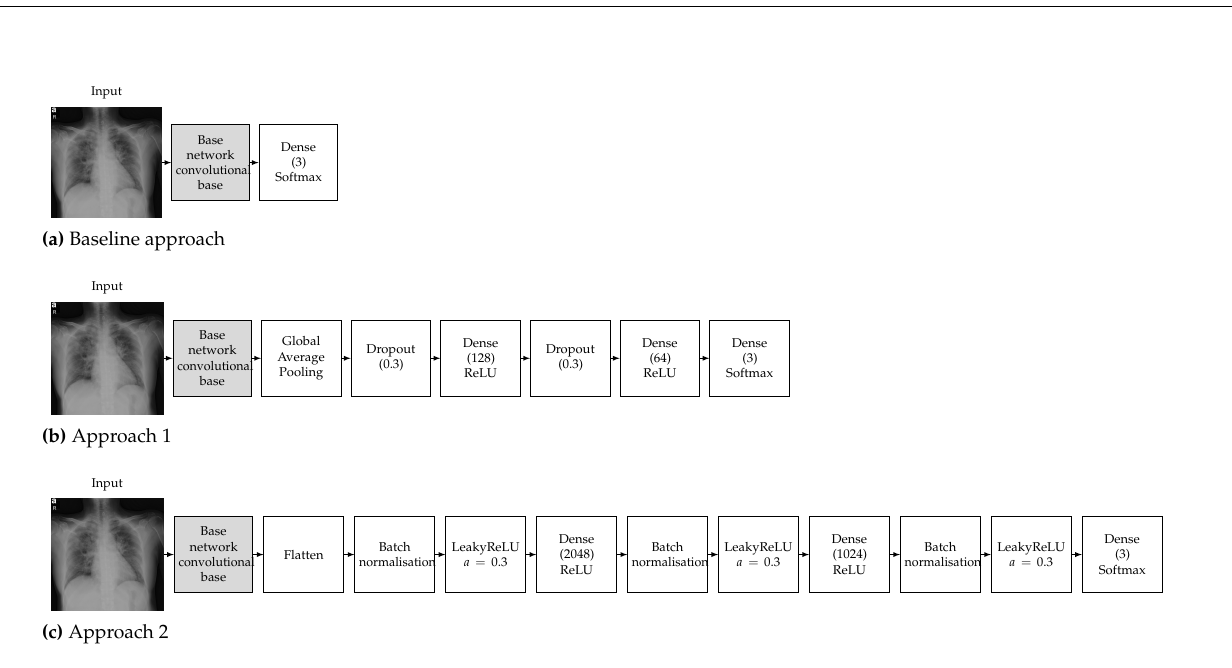
Figure 2. Proposed neural network architecture for the (a) Baseline approach, (b) Approach 1, (c) Approach 2.